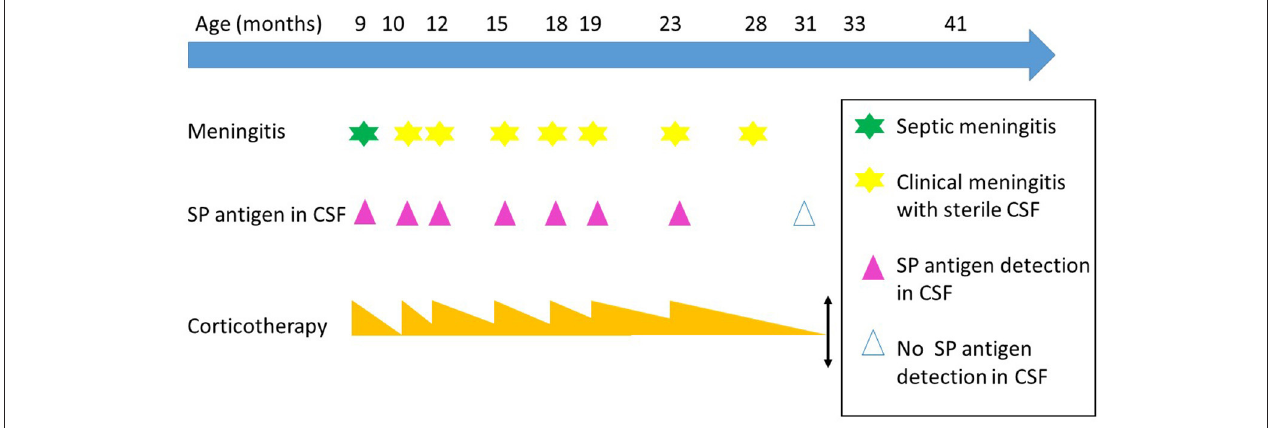
FIGURE 1 | Meningitis episodes over the times. SP, Streptococcus pneumonia; CSF, cerebrospinal fluid. Evolution over the time, the steroids therapy is represented by orange triangle, the height is proportional to the dosage of the medication.